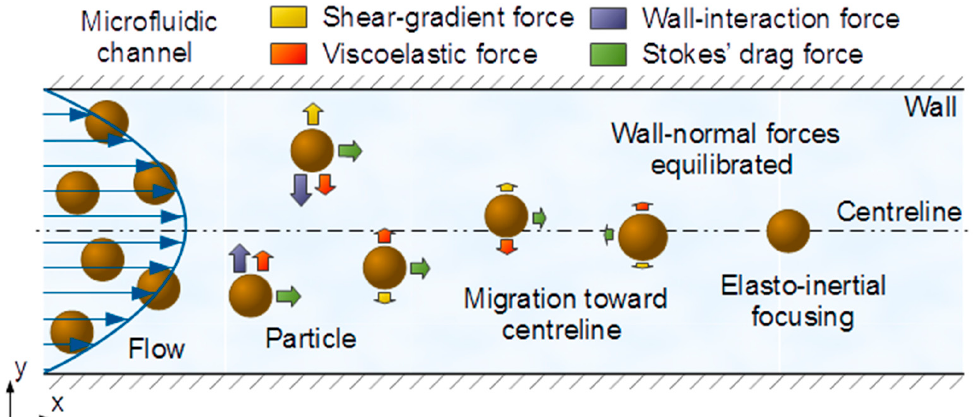
Figure 3. Illustration of the hydrodynamic forces acting on particles in an elasto-inertial microfluidic channel. The particles are randomly distributed at the inlet of the channel. The interaction, and final balance, of the wall-normal forces results in the focusing of the particles at the centerline. The main forces are shear-gradient lift force (yellow), wall-interaction force (violet), viscoelastic force (red) and Stokes’ drag force (green).